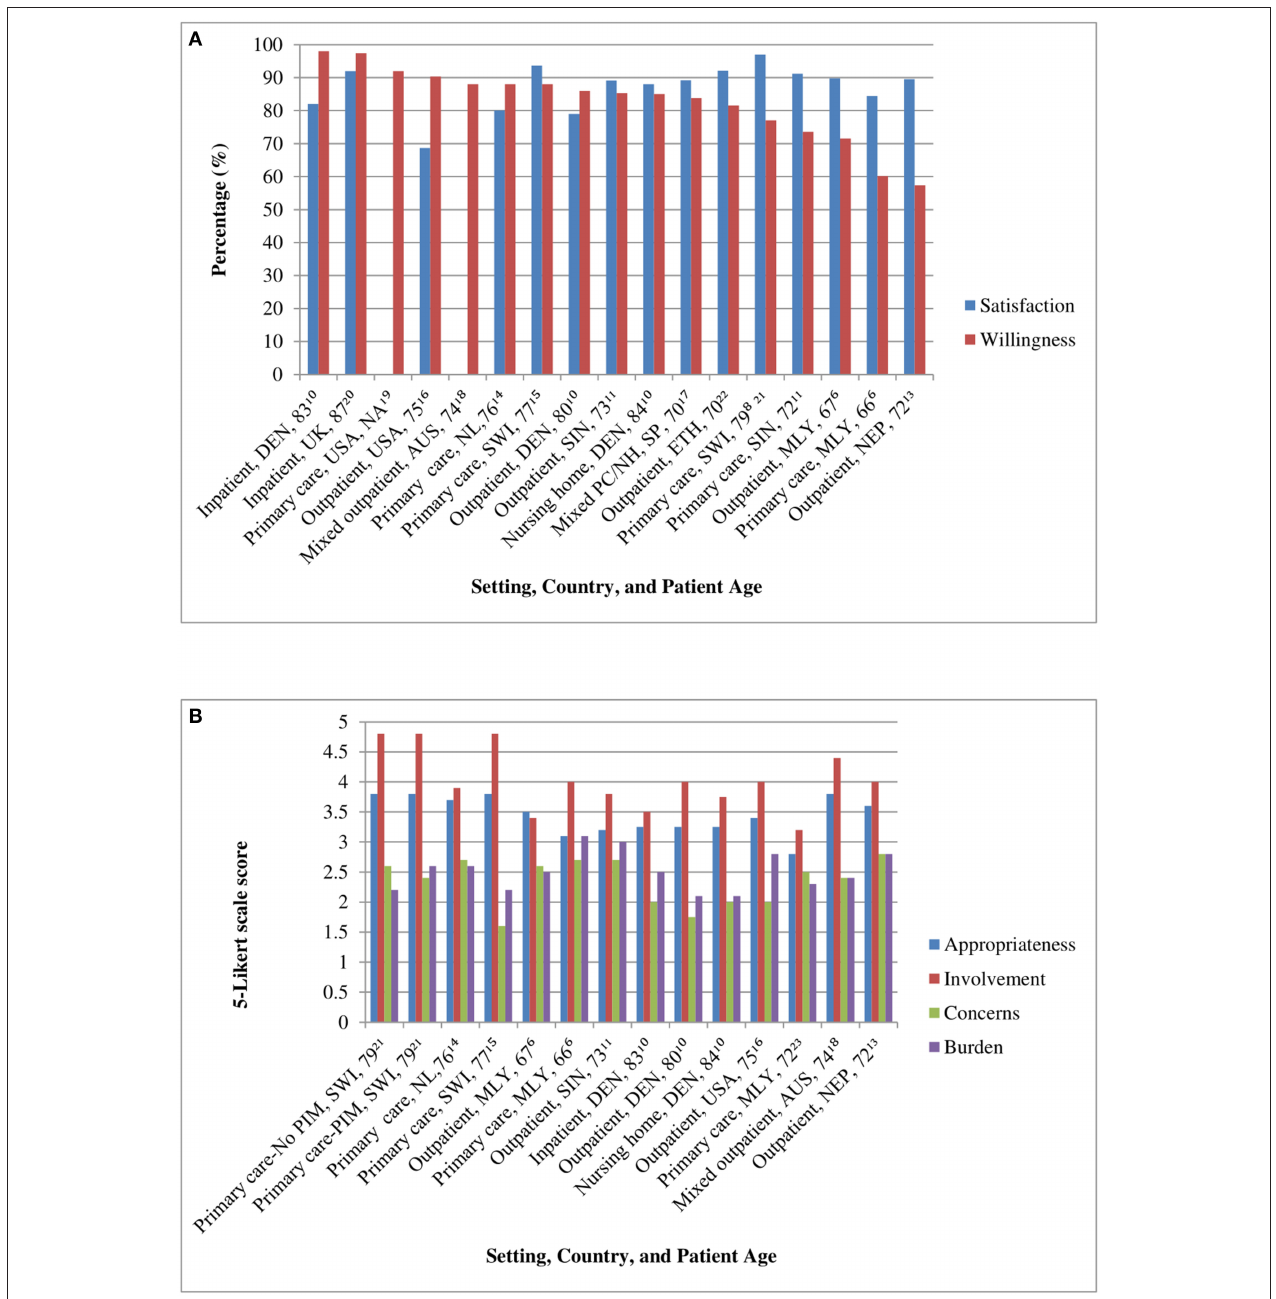
FIGURE 1 | (A) Satisfaction and willingness scores across study (sub)populations. Bars are presented with setting, country, and mean age of study (sub)population in the labels, including the reference number in superscript. DEN, Denmark; UK, United Kingdom; USA, United States of America; AUS, Australia; NL, Netherlands; SWI, Switzerland; SIN, Singapore; SP, Spain; ETH, Ethiopia; MLY, Malaysia; NEP, Nepal; NA, not assessed; PC/NH, primary care/nursing home. (B) rPATD factor scores across study (sub)populations. Bars are presented with setting, country and mean age of study (sub)population in the labels, including the reference number in superscript. rPATD, revised Patients’ Attitudes Towards Deprescribing; No PIM/PIM, subgroups without or with potentially inappropriate medication subgroups; SWI, Switzerland; NL, Netherlands; MLY, Malaysia; SIN, Singapore; DEN, Denmark; USA, United States of America; NEP, Nepal.